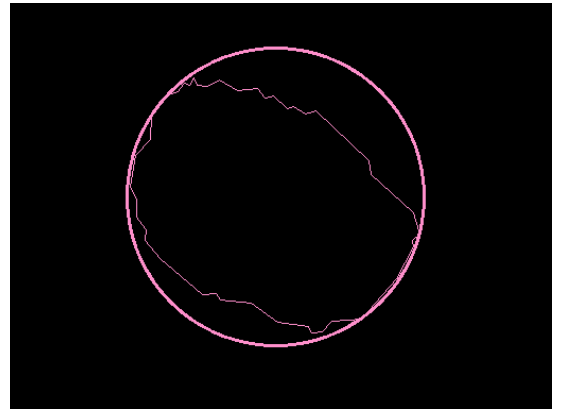
Figure 4. Circumference around the